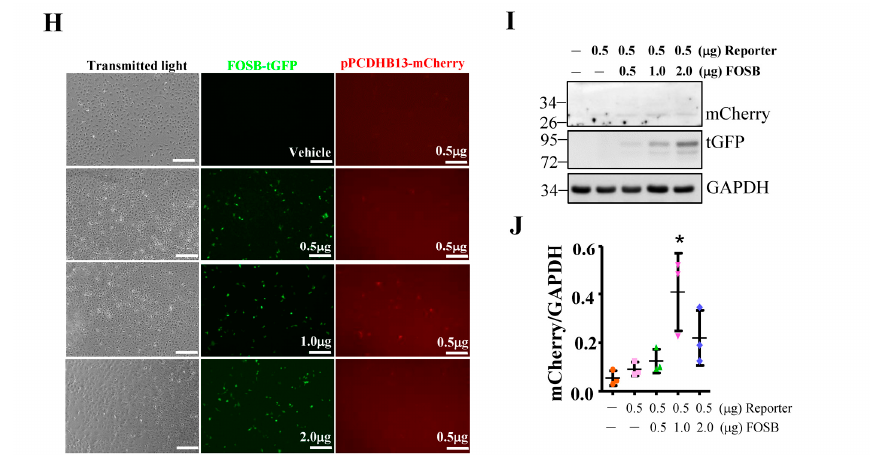
Figure 3. PCDHB13 is a downstream target of FOSB. ( A ) Total lysate from A549 cells transfected with control (Neg.) or FOSB siRNAs were analyzed by Western blot using antibodies against GAPDH and PCDHB13. ( B ) Quantitative analyses of PCDHB13 levels in ( A ) normalized to GAPDH. ( C – G ) Quantitative PCR following ChIP assay to confirm putative FOSB target sites in the PCDHB13 promoter. Two primer sets were used for qPCR studies ( C ). RNA Pol II antibody and a qPCR primer-pair flanking the GAPDH promoter served as positive controls, while non-specific rabbit IgG antibody served as a negative control. The ChIP-qPCR signals are normalized to Rabbit IgG signals, showing the fold enrichment relative to the background ( D – G ). Results represent mean ± SD. PCR amplicons were electrophoresed on a 1.5% agarose gel to confirm specificity of amplification. ( H ) Transmitted light and fluorescent images of A549 cells transfected with reporter or cotransfected with reporter and FOSB. Bar: 100 µ m. ( I ) Total lysates from A549 cells transfected with reporter or cotransfected with reporter and FOSB were analyzed by Western blot using antibodies against tGFP, GAPDH, and FOSB. ( J ) Quantitative measurements of protein levels were normalized to GAPDH ( I ). Quantitative results represent the mean ± SD ( n = 3, two tailed t -test: * p <